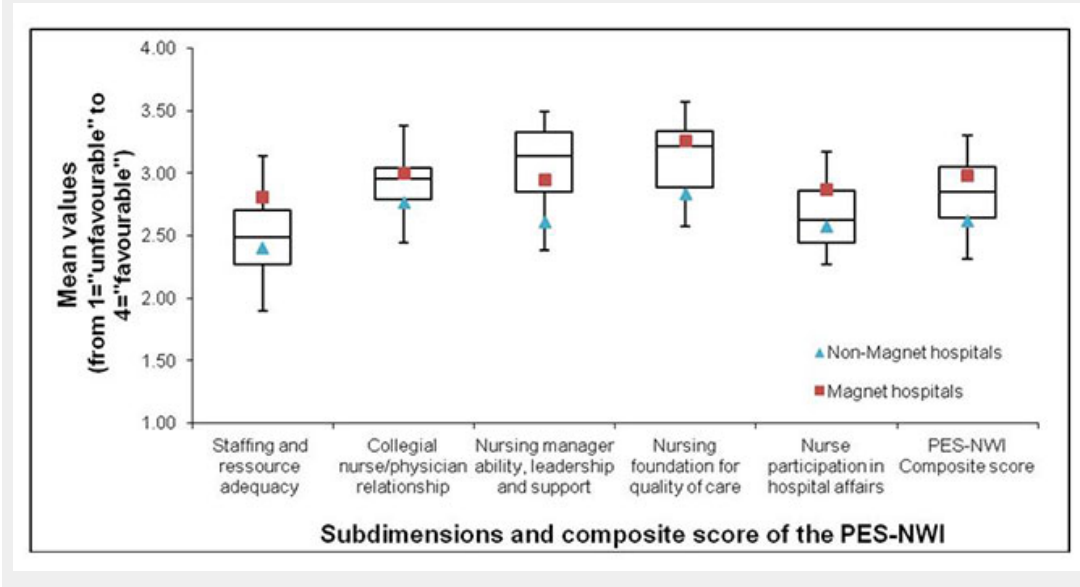
The quality of the nurse work environment in our sample (box plots), compared to work environments in Magnet and Non-Magnet hospitals